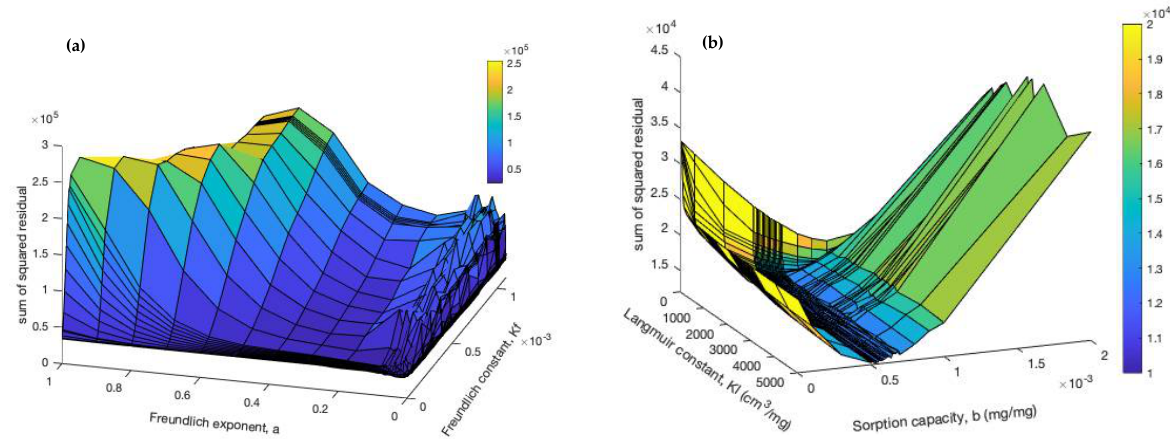
Figure 7. Goodness of fit in the simulation of toluene transport: ( a ) Freundlich isotherm model; ( b ) Langmuir isotherm